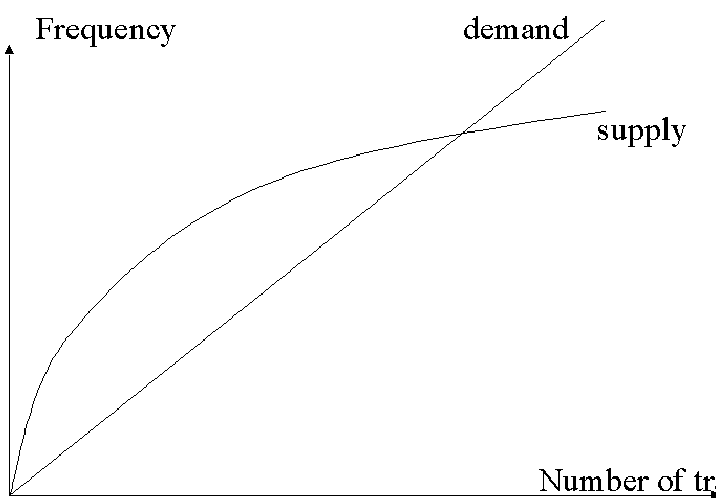
Figure 1. The relationship between capacity and travel demand according to the square root